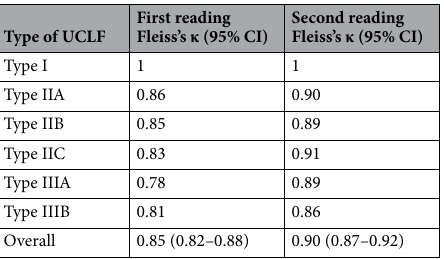
Table 2. Inter-observer reliability according to various types.